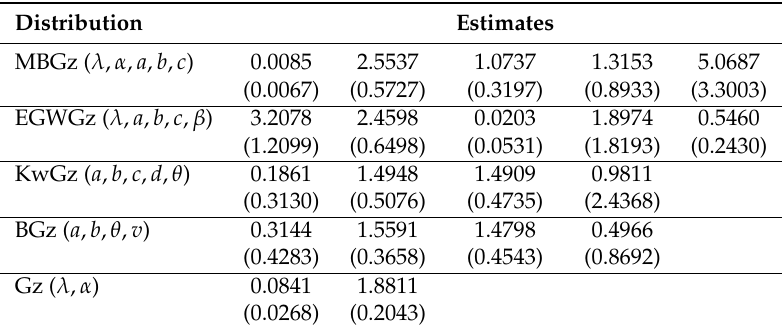
Table 2. MLEs (standard errors in parentheses) for Dataset 1.